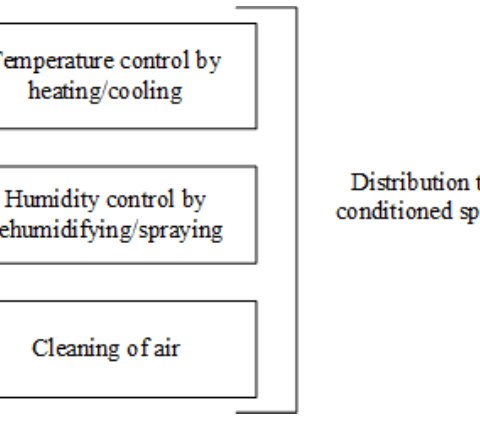
Figure 1. The functions of air conditioning